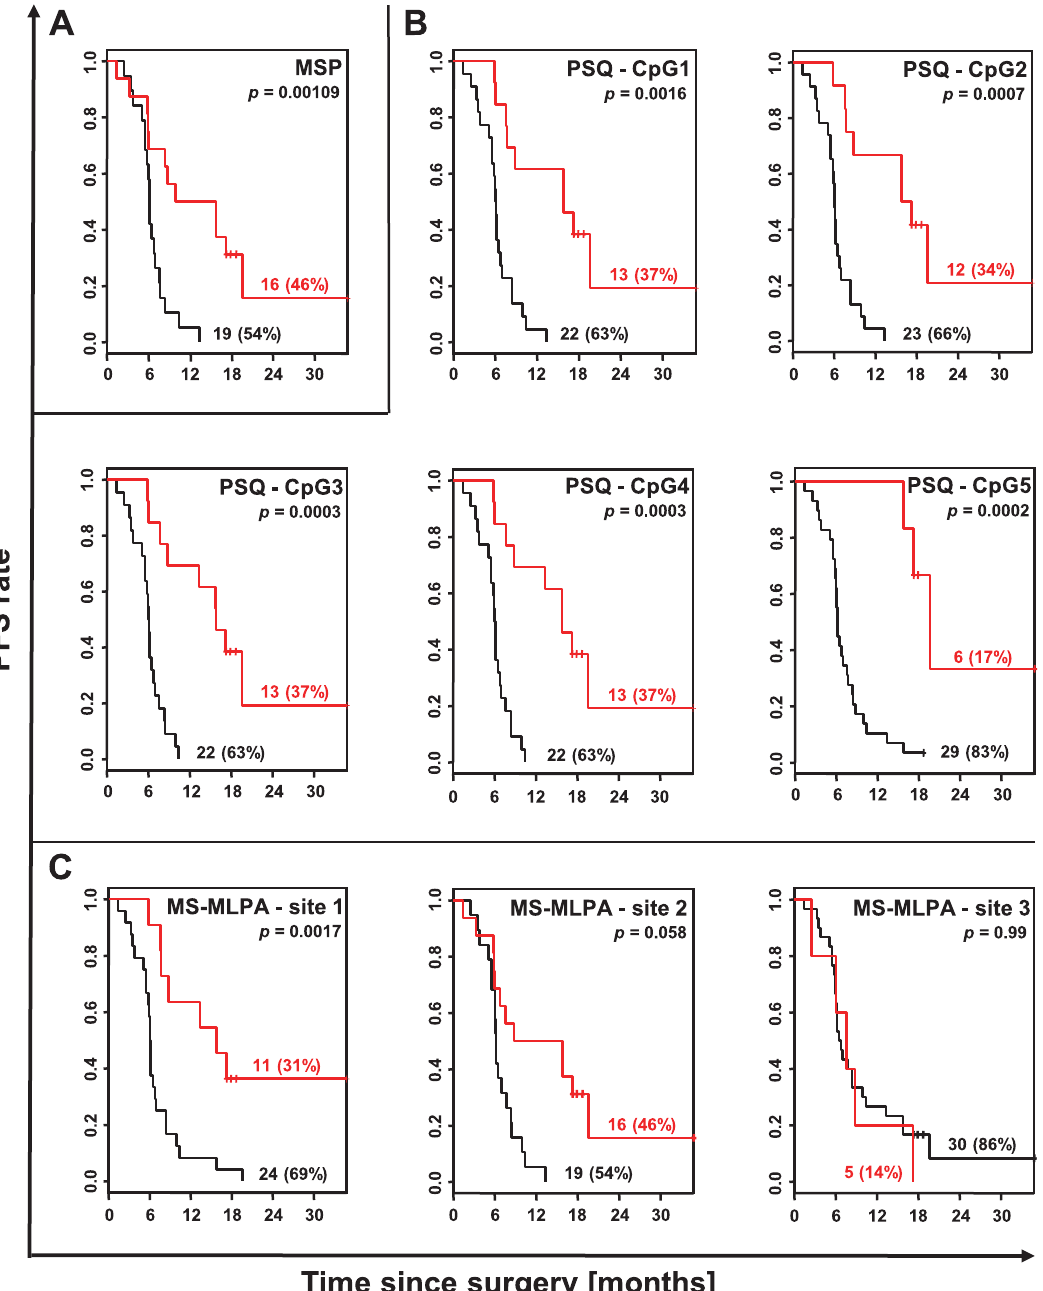
Figure 2. Method-dependent Kaplan-Meier estimates of PFS. PFS data for binary methylation covariates were obtained from ( A ) MSP, ( B ) PSQ CpG sites 1 to 5 and ( C ) MS-MLPA sites 1 to 3 based on missing data imputation ( n =35) for each diagnostic method applied. Respective cut-points allowing the conversion from continuous to binary methylation data in (B) and (C) are indicated in Table 2. Of note, Kaplan-Meier curves for MS-MLPA sites 2 and 3 were computed on grounds of insignificant cut-points (see Table 2). Respective p values of the maximally selected log-rank test and respective numbers (percentages) of tumours assigned to each group, methylated or unmethylated, are given in each plot. Black curves, unmethylated; red curves, methylated. doi:10.1371/journal.pone.0033449.g002 (Figure 3A) reflecting the relative inferiority of this method as proved by the likelihood ratio tests (Table 3). With respect to OS, neither PSQ nor MS-MLPA data additionally decreased the of the MGMT status has become state-of-the-art in current and prediction error of the Kaplan-Meier reference to a relevant planned clinical trials in glioma as a prognosticator, to stratify extent, whereas MSP demonstrated a clear-cut improvement of patients or even to limit trial entry accordingly. Moreover, it is OS prediction (Figure 3B).